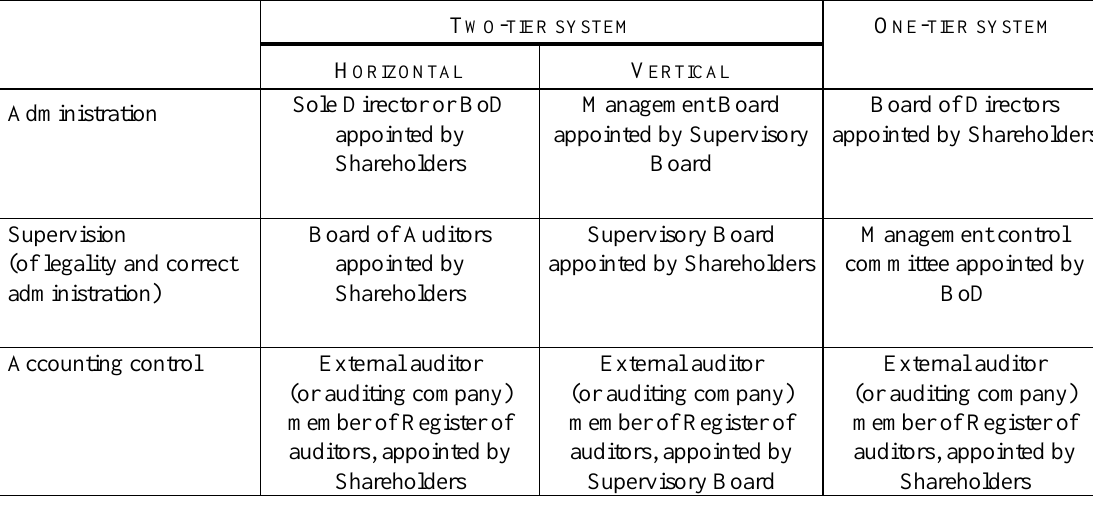
Table 1: Models of Corporate